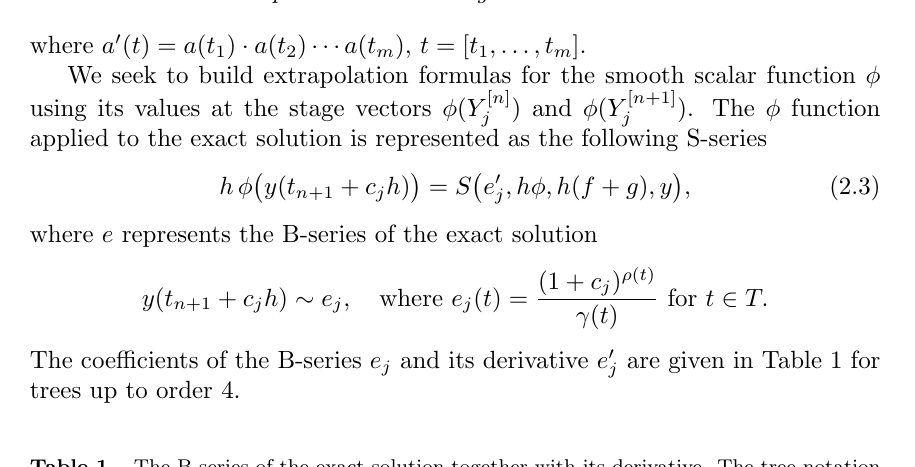
Table 1. The B-series of the exact solution together with its derivative. The tree notation follows the one in [15, Table 2.2, page 148].